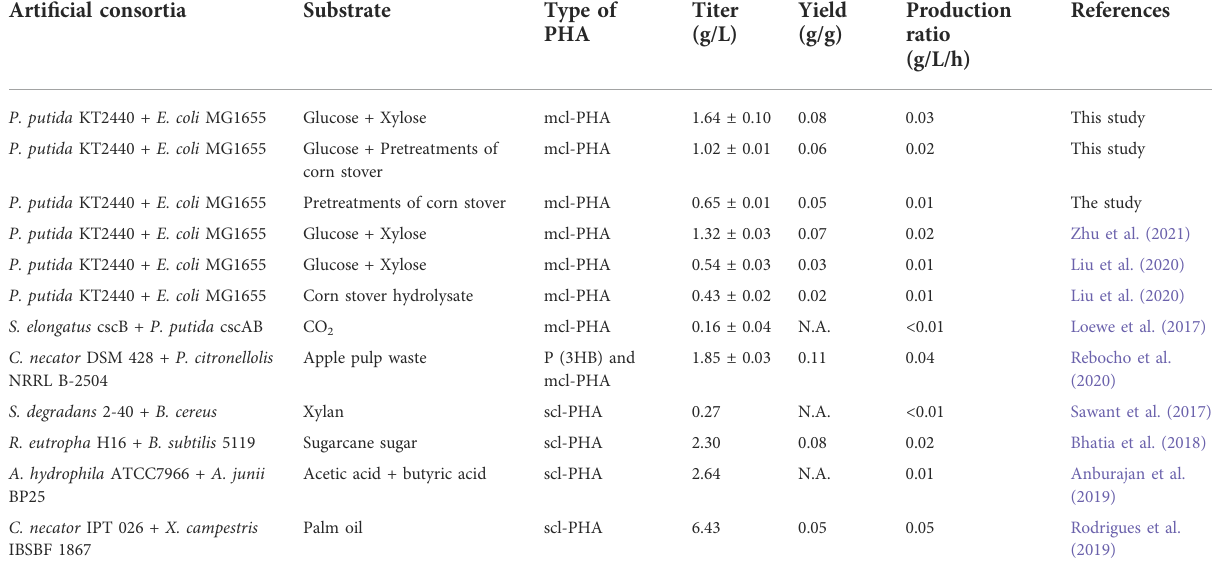
TABLE 2 Research on arti fi cial consortia for PHA